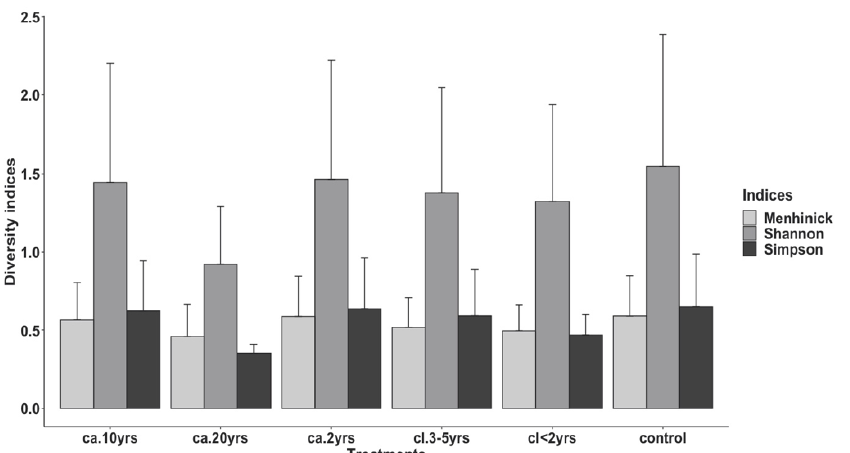
Figure 1. Mean ± SE of the diversity indices of large mammals of the Groenkloof Nature Reserve from areas of different treatments of L. camara invasion durations ( ca. 2 yrs; ca. 10 yrs and ca. 20 yrs), differing L. camara clearing times ( cl <2 yrs and cl. 3 – 5 yrs), and a control area with no history of L. camara invasion. See Supplementary Table S1 for treatments and indices definitions.